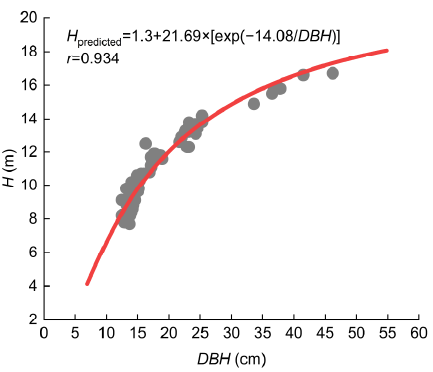
Figure 2. Observed scatter and predicted H - DBH function curve of T . Zhongshanshan plants.